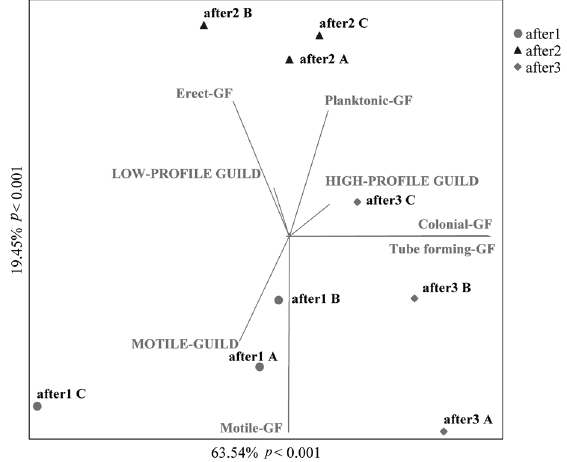
Figure 2 - Principal Component Analysis using diatom’s guilds and growth forms (gF) showing temporal variation after the oil spill (A,B,C are the replicates from the same sampling